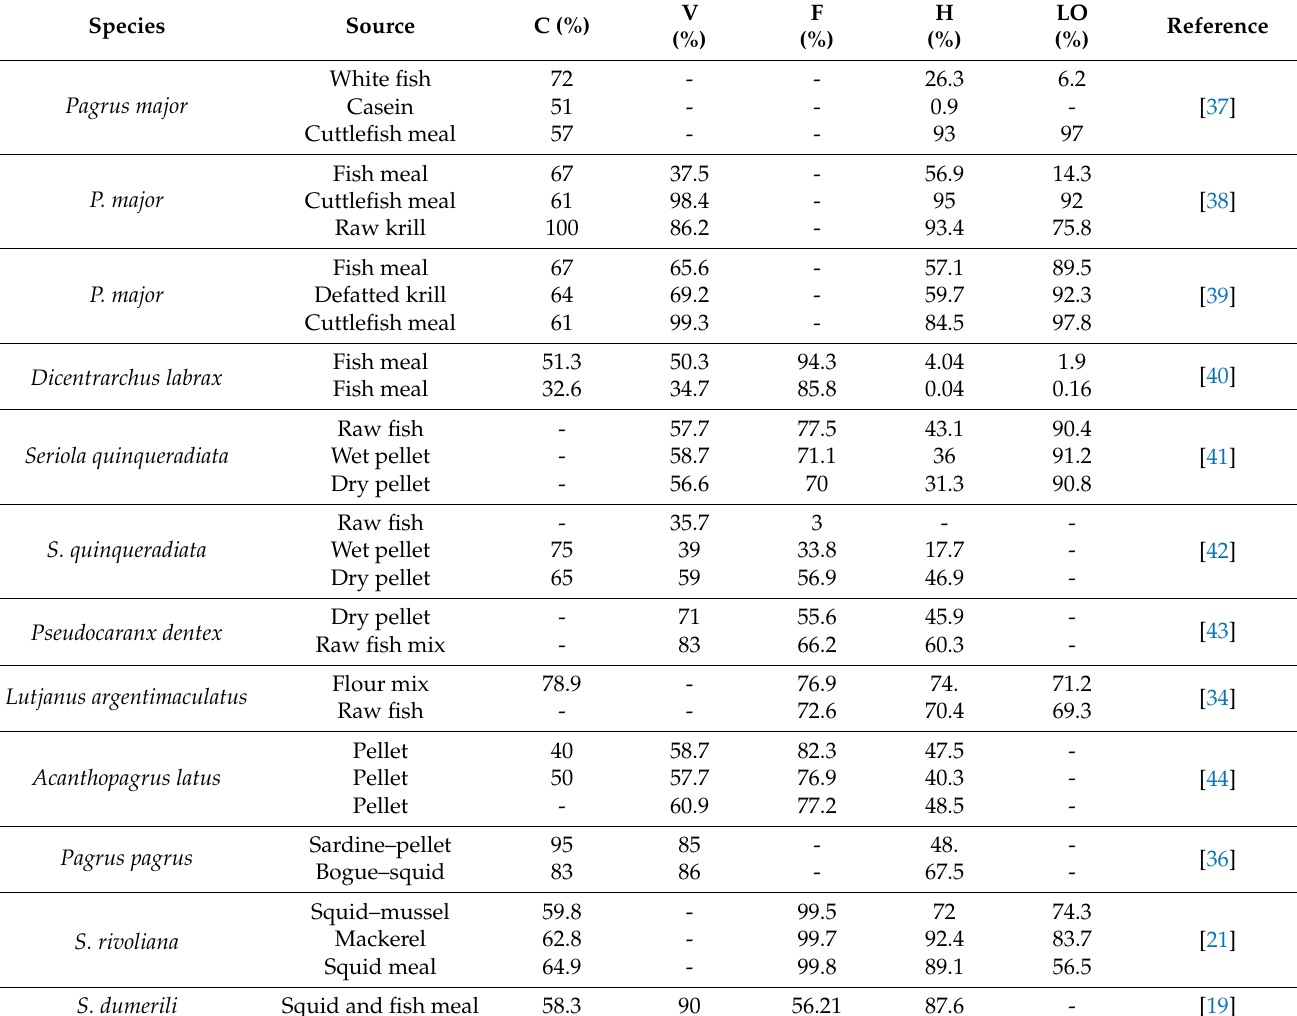
Table 2. Reproductive performance of different species fed different protein sources and concentra- tions. C: Concentration; V: Viable eggs; F: Fertilization; H: Hatching; LO: Larvae